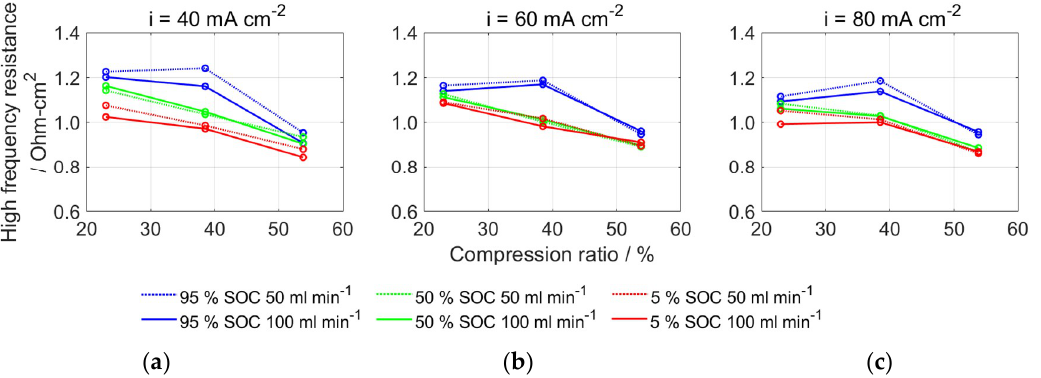
Figure 8. Effects of CR on the high frequency resistance of the VRFB operating under various operating conditions: ( a ) 40 mA cm −2 ; ( b ) 60 mA cm −2 ; ( c ) 80 mA cm −2 .